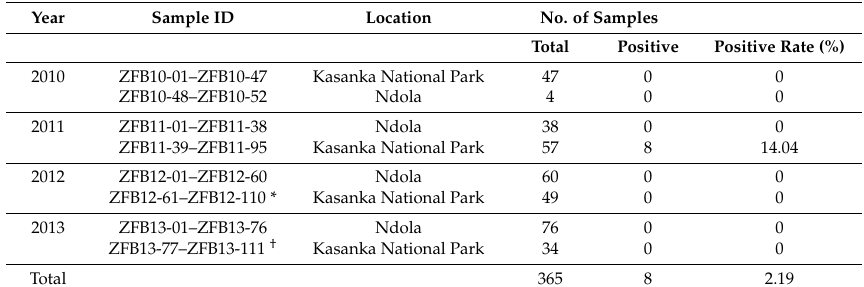
Table 3. Detection of bat-derived adenoviruses from E. helvum kidney DNA.